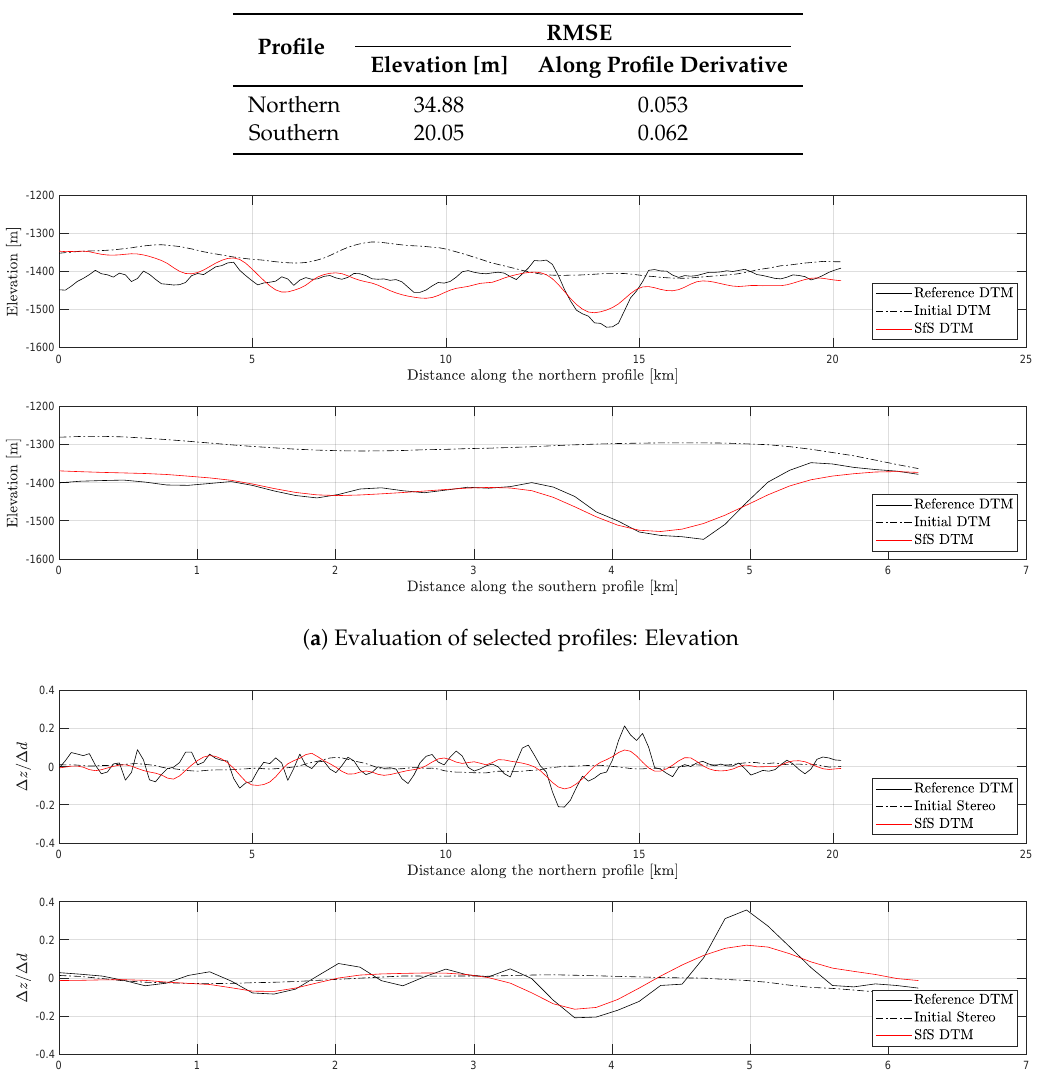
Table 6. RMSE of elevation and along profile derivative of the SfS profiles to the reference DTM profiles from Figure 11 at a resolution of 155m/pixel.